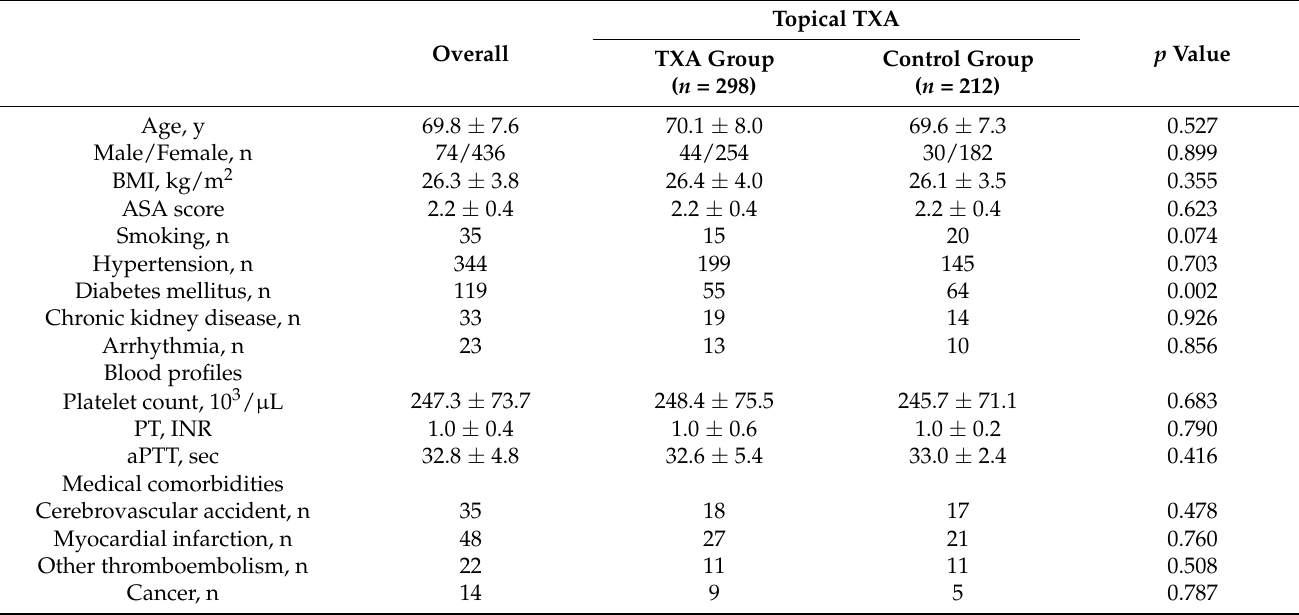
Table 1. Patient characteristics between the TXA and the control groups before